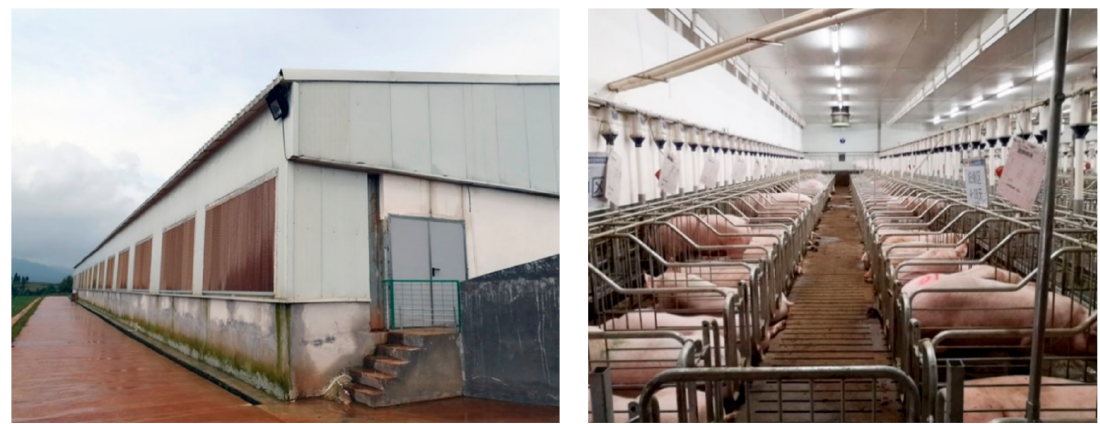
Figure 1. The gestation sow housing of this study in Yunnan Province.